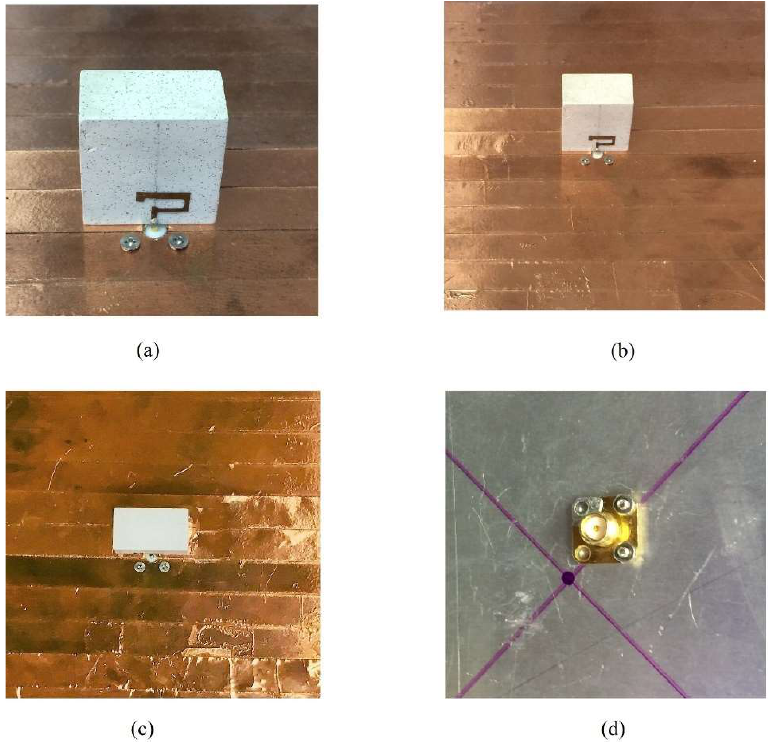
Figure 11. The geometry of the Proposed CP 5G RDRA Photograph of the prototype of the CP 5G RDRA. ( a ) Closeup; ( b ) Front View; ( c ) Top view; ( d ) Back view.